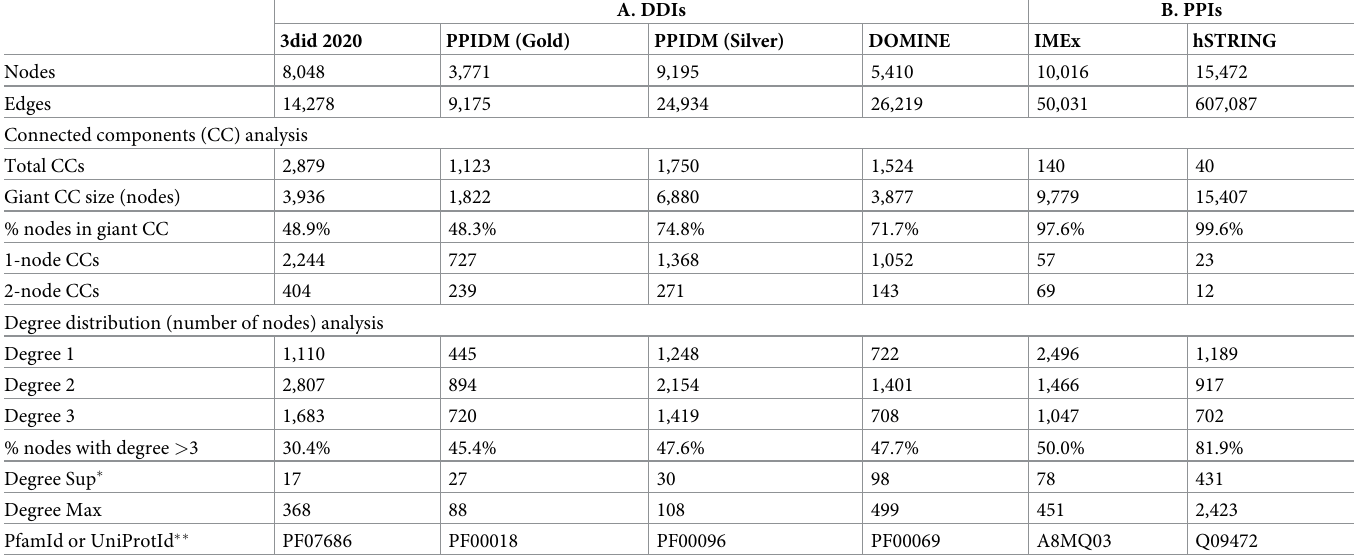
Table 5. Comparison of network statistics for (A) DDI networks: 3did2020, PPIDM (Gold), PPIDM (Silver), DOMINE, and (B) PPI networks used for PPIDM eval- uation: IMEX and hSTRING. � Degree Sup is the superior degree value for 99% of the nodes ranked according to increasing degree. �� PfamId or UniProtId correspond- ing to the nodes having the maximal degree. PF07686: Immunoglobulin V-set domain; PF00018: SH3 domain; PF00096: Zinc finger, C2H2 type, domain; PF00069: PKinase domain; A8MQ03: Cysteine-rich tail protein 1; Q09472: Histone acetyltransferase